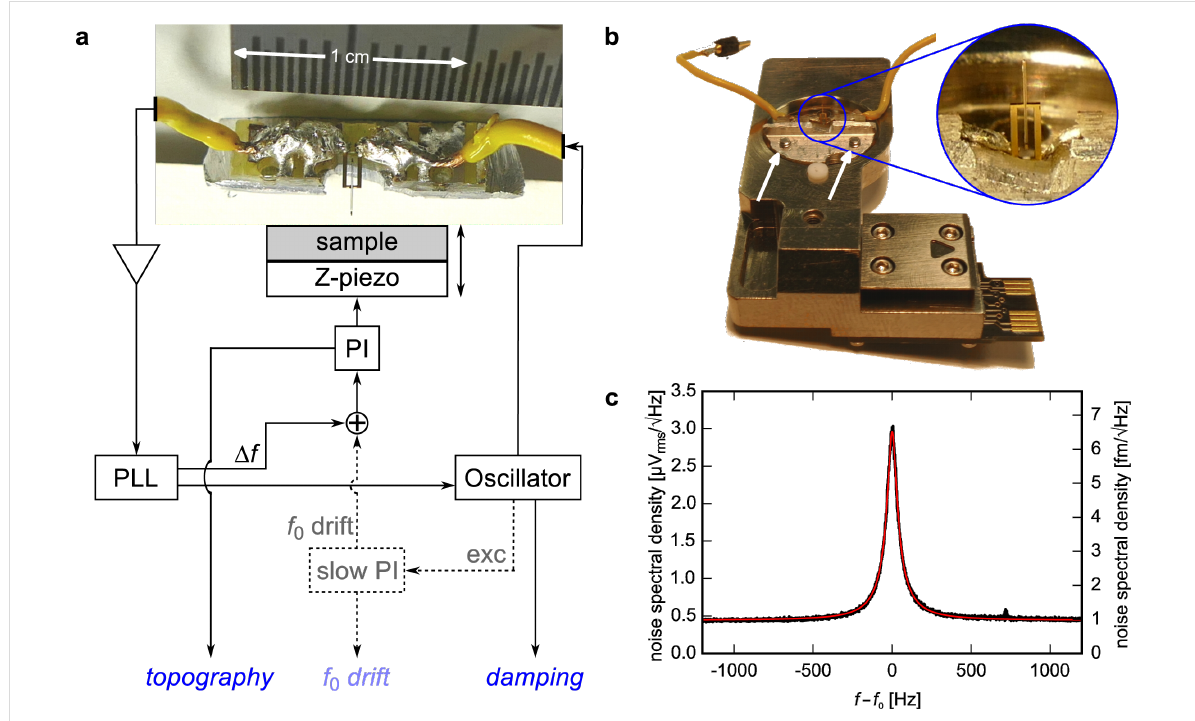
Figure 1: Experimental setup. a) Feedback scheme. The dashed parts enable the slow-drift compensation. Also shown is the LER soldered on a piece of a circuit board, which is glued to an L-shaped metal adapter piece. b) Image of the Cypher droplet holder with LER adapter piece fixed by two screws (white arrows). c) Thermal noise spectrum (black) of a LER with a SSS-NCHR tip attached and a fit of a damped harmonic oscillator (red). The right axis is obtained by multiplying the left axis with the inverse sensitivity 1/ S = 2.2 nm/V rms . Parameters derived from the fit: Q = 17,000, f 0 = 999.3 kHz. The detector noise density is 1.0 fm/ .